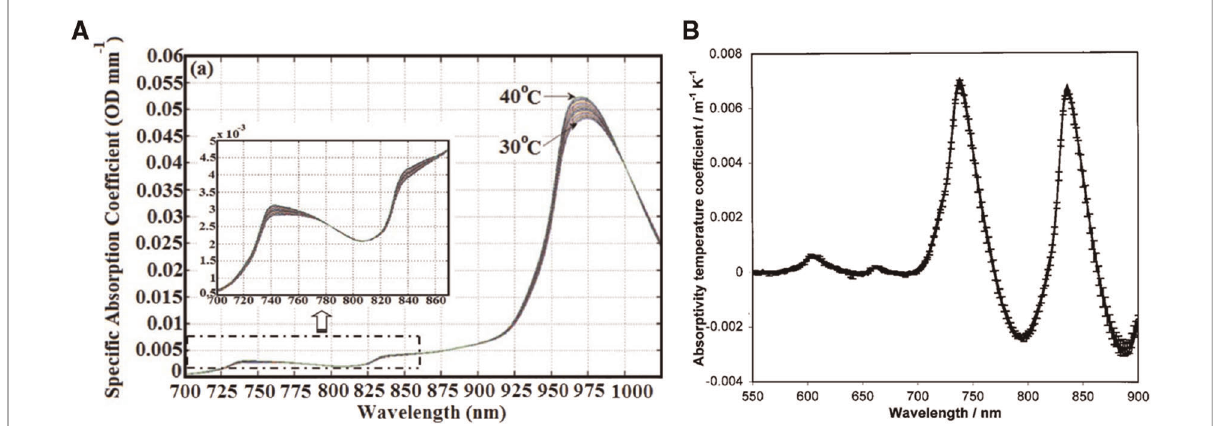
FIGURE 2 NIRS thermometry. Left ( A ) - NIR absorption spectra of pure water at various temperature. Extracted from Hollis et al. (74). Right ( B ) - Absorptivity temperature coef fi cients (da/dT) for the 550 – 900 nm. Extracted from Langford et al.